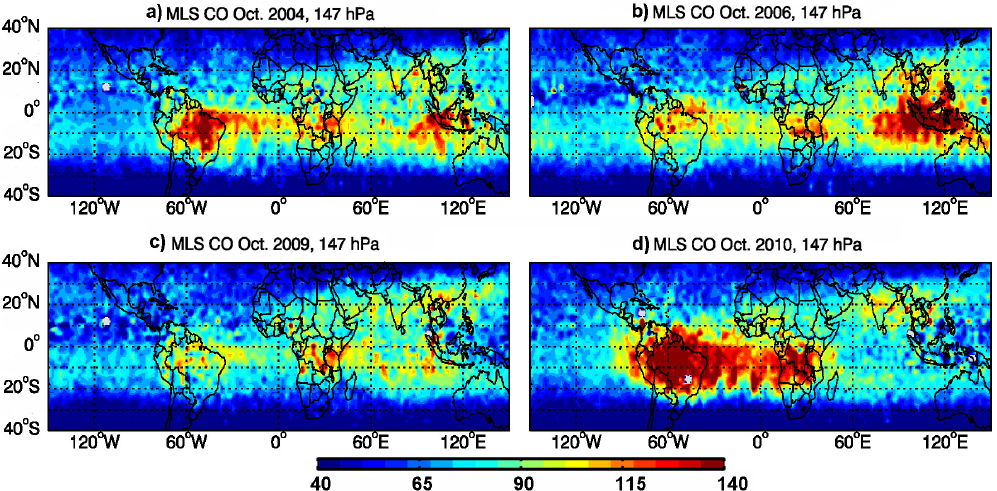
Fig. 8. Spatial patterns of MLS monthly mean CO mixing ratios at 147 hPa for October 2004, 2006, 2009 and 2010 during the Southern Hemisphere biomass burning season.